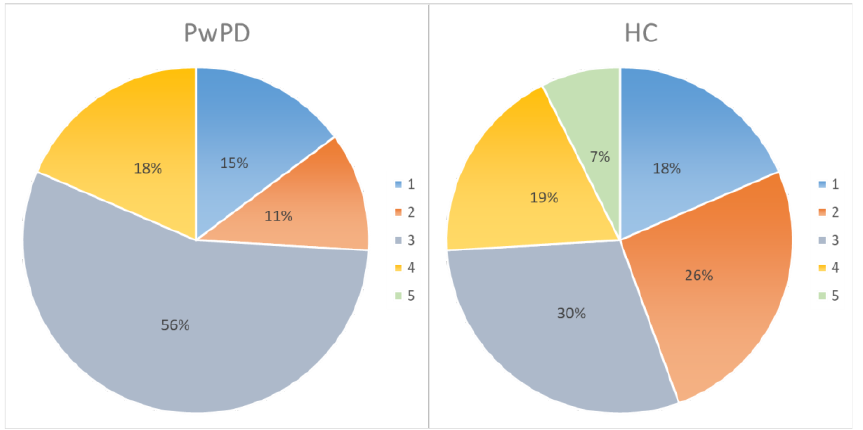
Figure 3. Percentages relating to familiarity with the technologies for each group. PD, Parkinson’s disease; HC, healthy control. 1 = never; 2 = once a month or more rarely; 3 = once a week; 4 = every 2/3 days; 5 = every day.